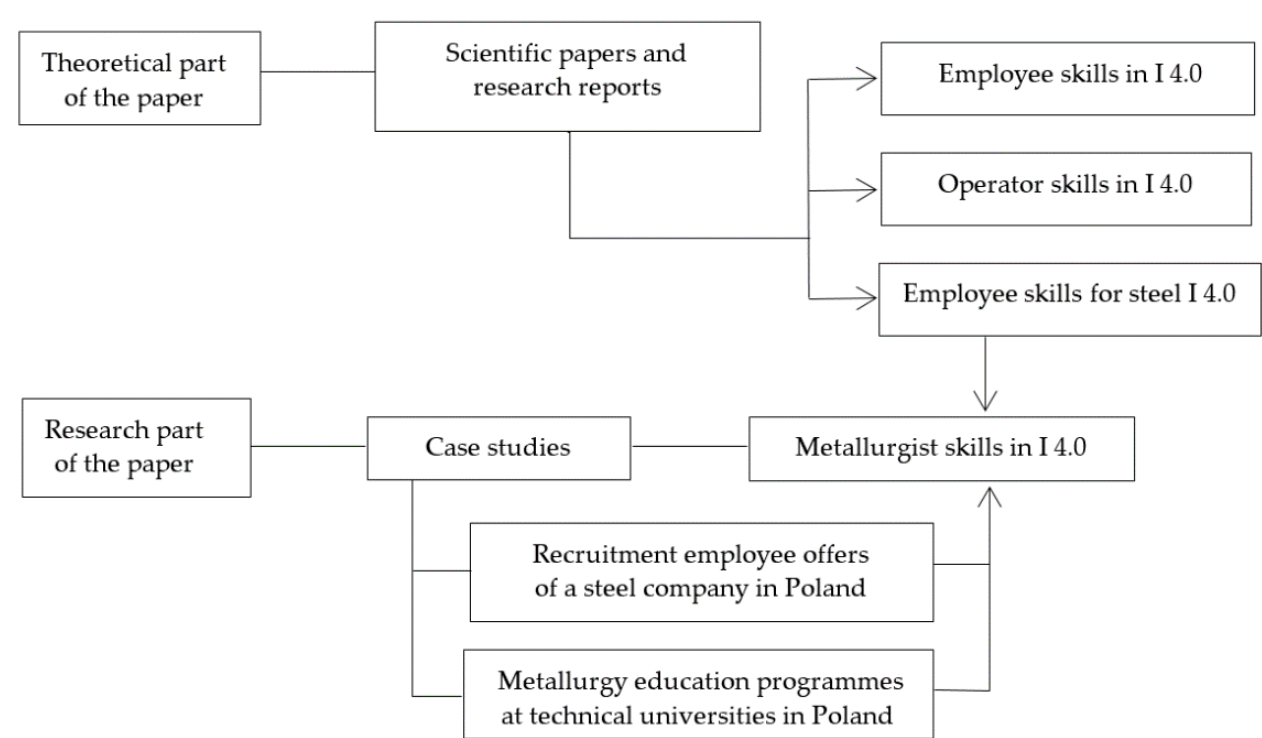
Figure 1. Research methodology in setting the frameworks of employee profiles for smart manufac- turing.